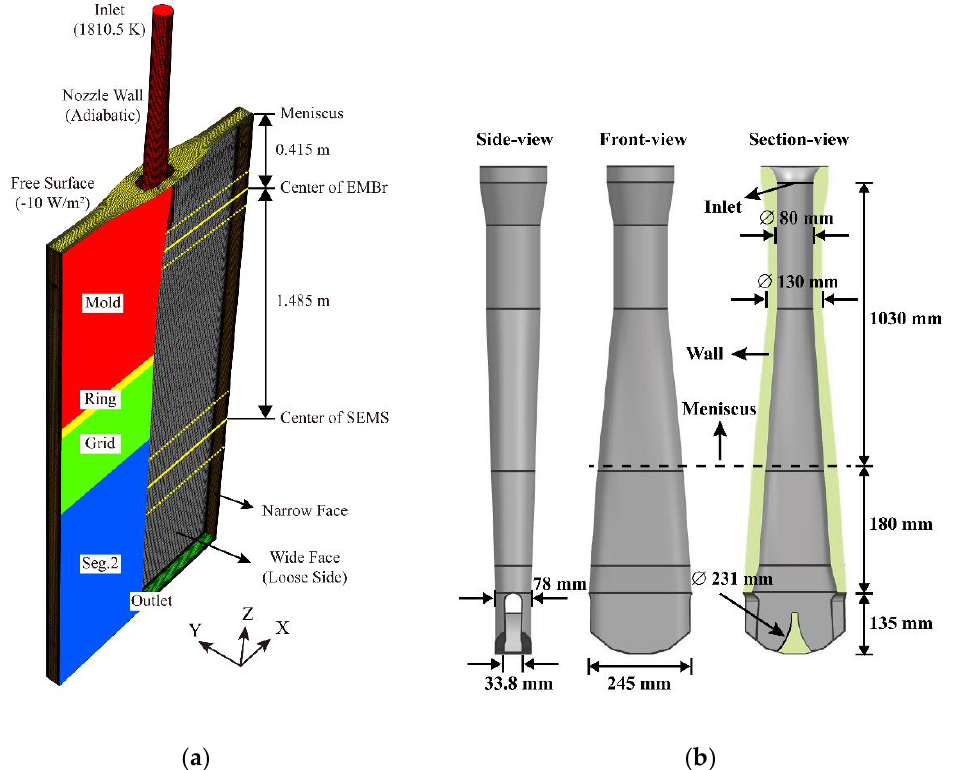
Figure 3. ( a ) Physical model and boundary conditions. ( b ) Geometry of the SEN.